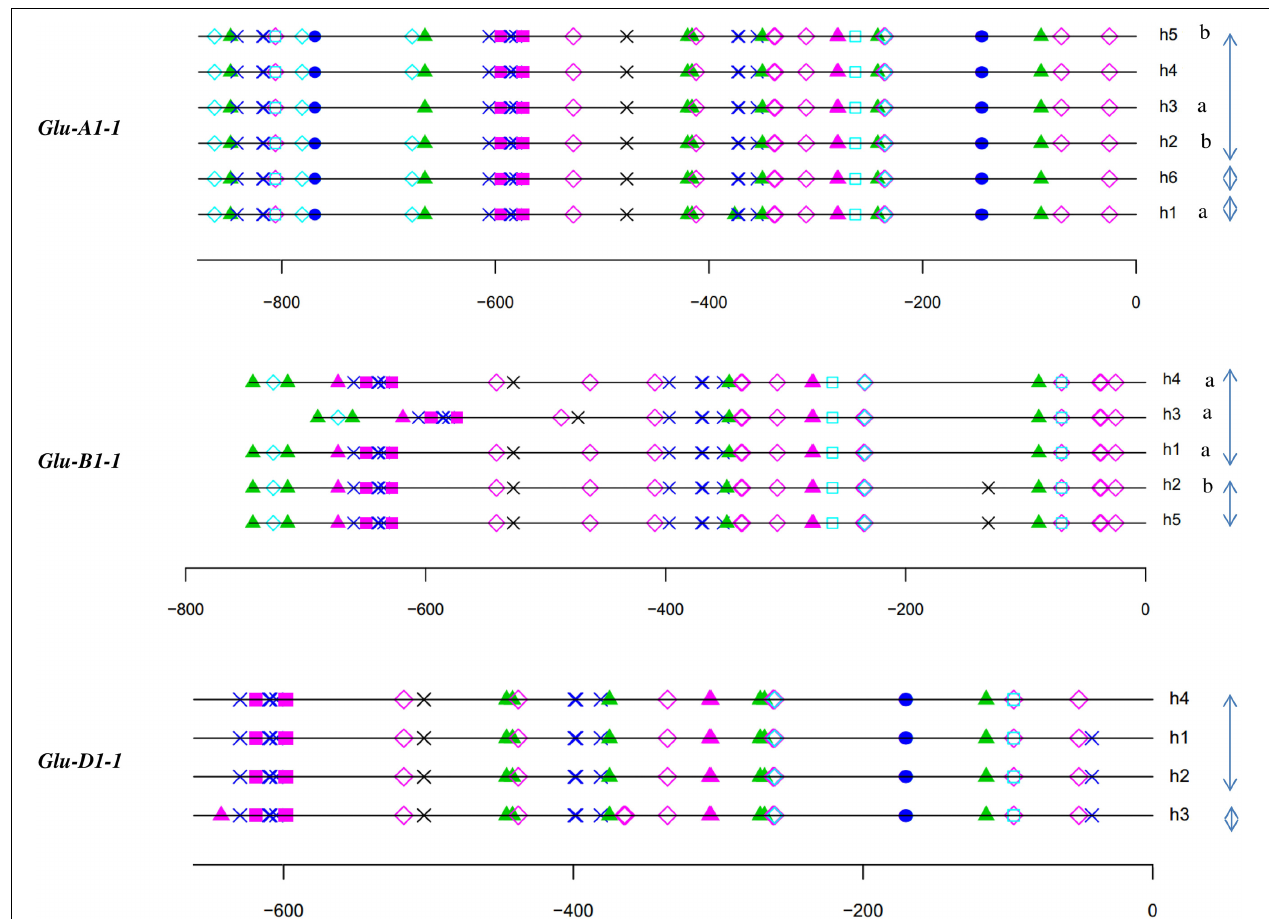
FIGURE 3 | In silico annotation of the x-type HMW-GS gene promoter haplotypes. Positions are indicated relative to the transcription start site. Sequences were obtained from a set of 42 lines representative of the genetic diversity of the INRA worldwide hexaploid wheat core collection. For each gene, the haplotype of the promoter is indicated by the letter h followed